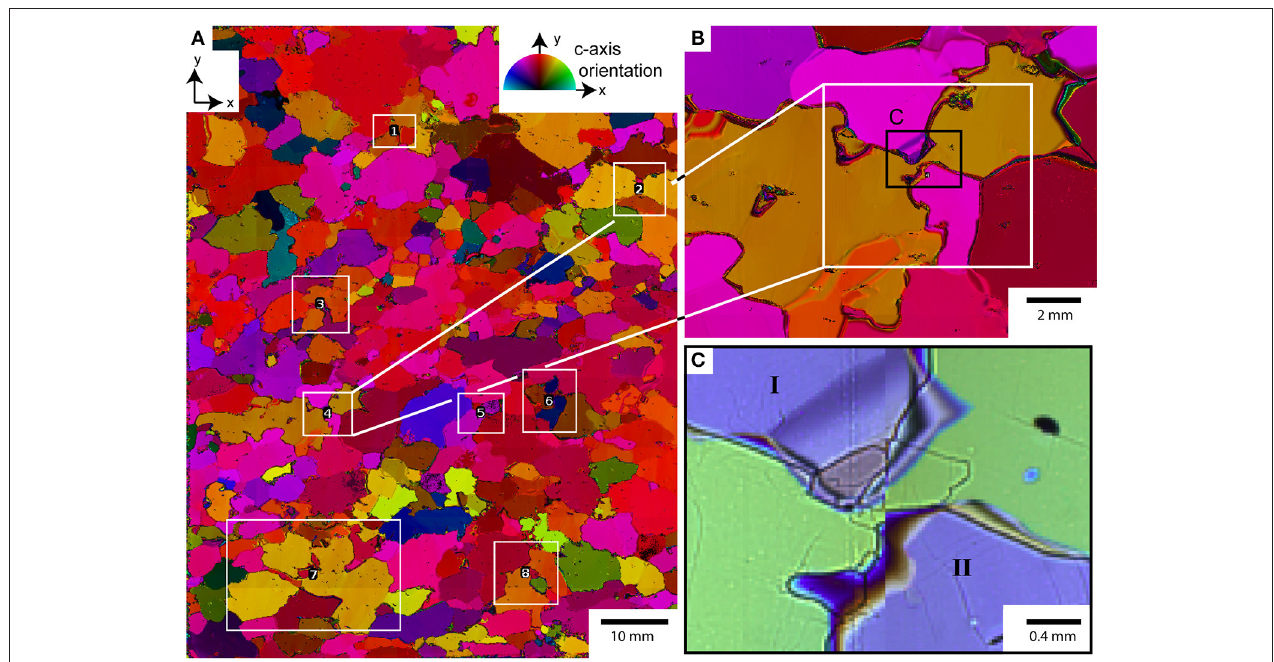
FIGURE 9 | Grain dissection events in c-axis map, y-axis parallel to (vertical) core axis. (A) C-axis orientation map of a 7 × 9 cm thin section from the NEEM ice core at 1211.7 m. Colors indicate the azimuth of c-axes relative to the vertical y-axis. Imminent dissection events are marked with white rectangles. (B) Detail of a dissection event. Grain boundaries are highly irregular due to dynamic recrystallization. The orange grain is almost split in two grains that are still connected through a very narrow bridge. (C) Photomicrograph, with cross-polarized light, of the same spot showing the connecting bridge in detail. Dark lines are grain-boundary grooves at the surface. Subgrain-boundaries develop at the thin bridge between the dissected